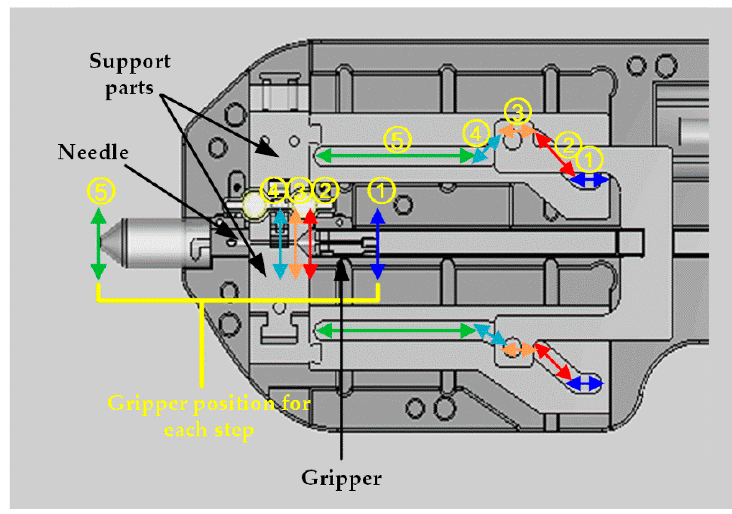
Figure 10. Guide structure for needle transfer.